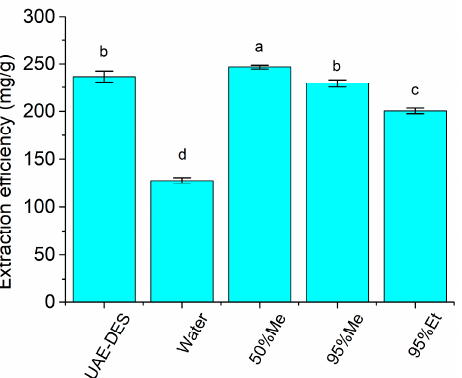
Figure 2. Extraction efficiencies of prepared DES and conventional solvents (50%me-50% methanol, 95%me-95% methanol, and 95%et-95% ethanol). Values followed by different letters (a–d) are significantly different according to Duncan’s test (p < 0.05).